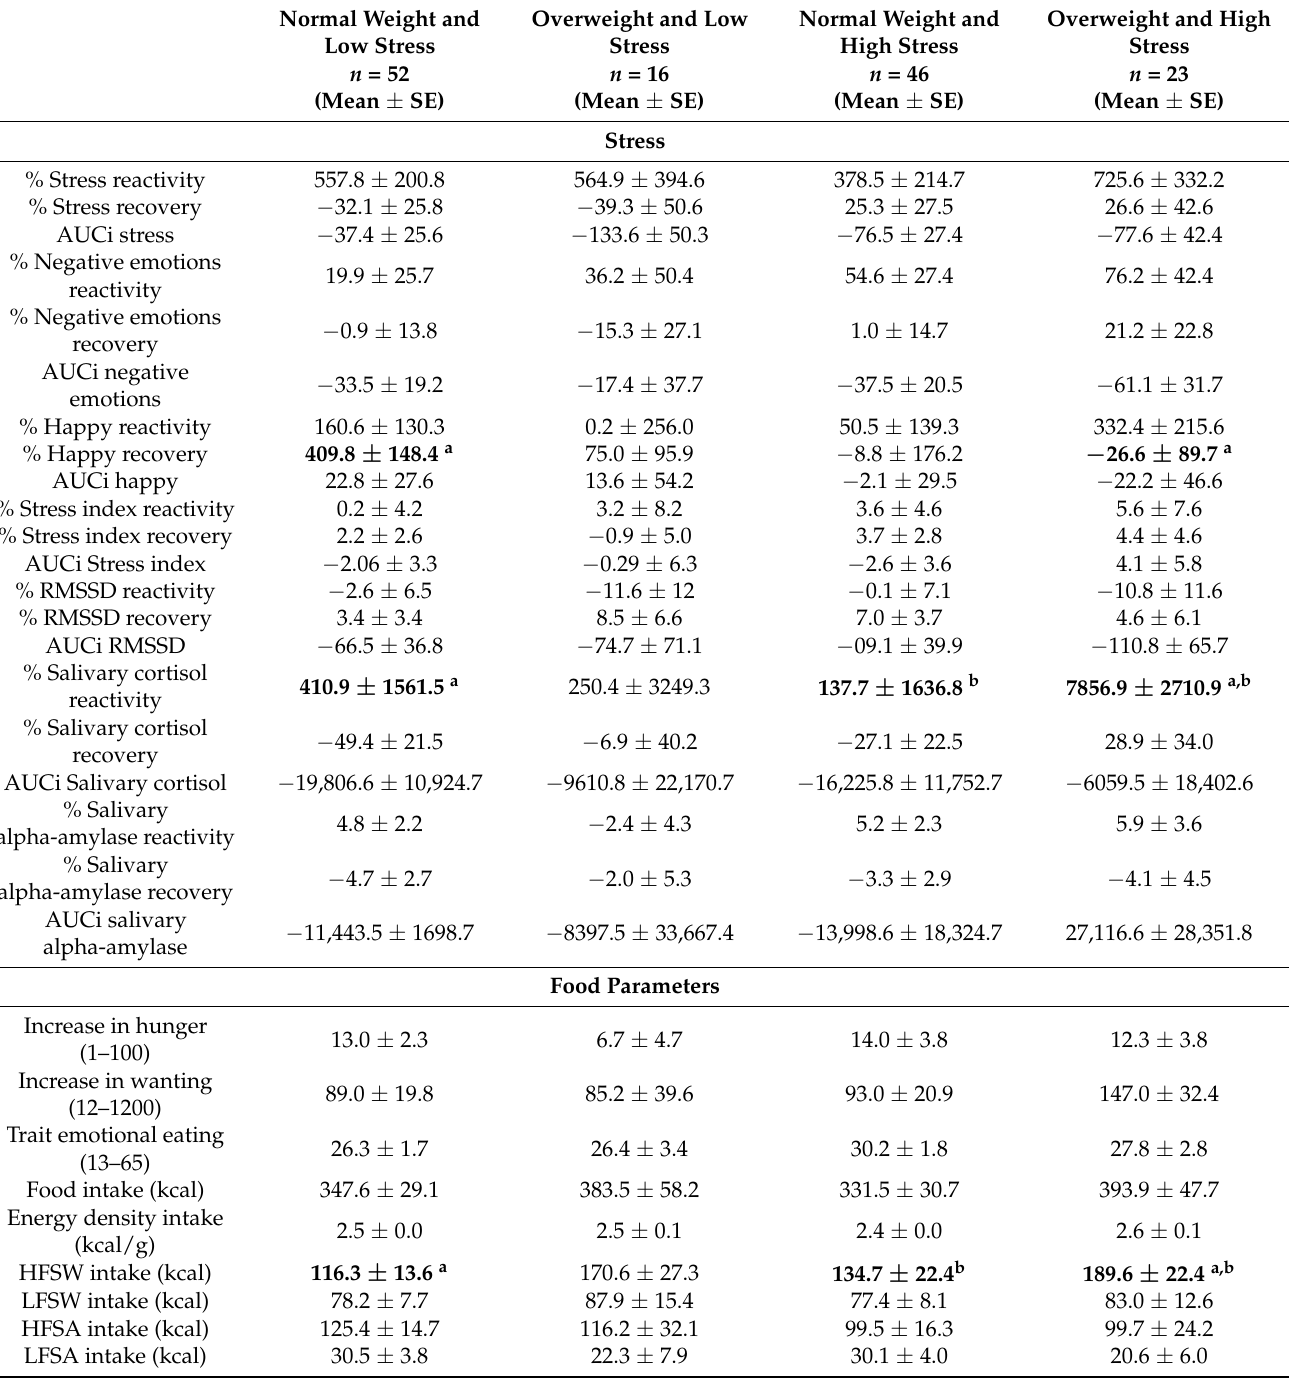
Table 2. Group differences in stress response and food parameters after Trier Social Stress Test